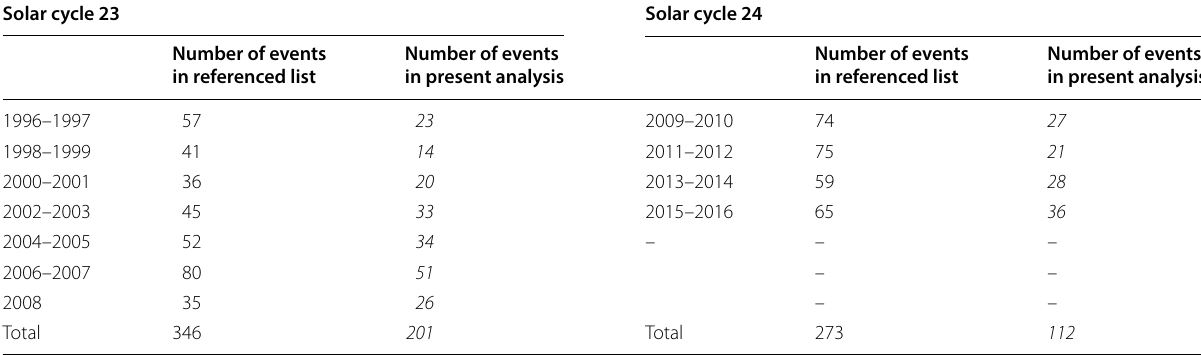
Table 1 The number of events every 2 years and all year in referred CIR/SIR list and the present study